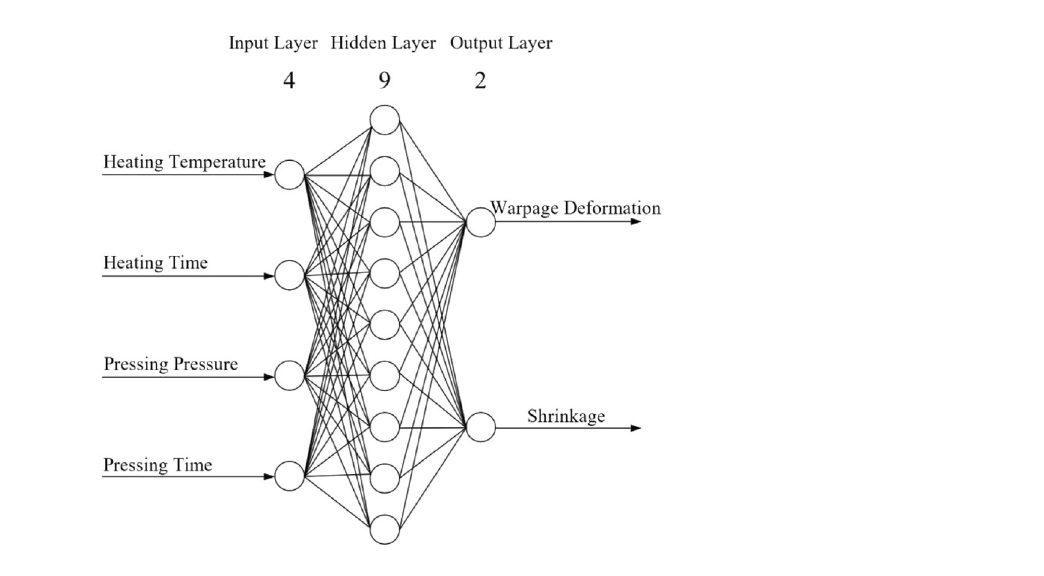
Figure 19. Neural network structure